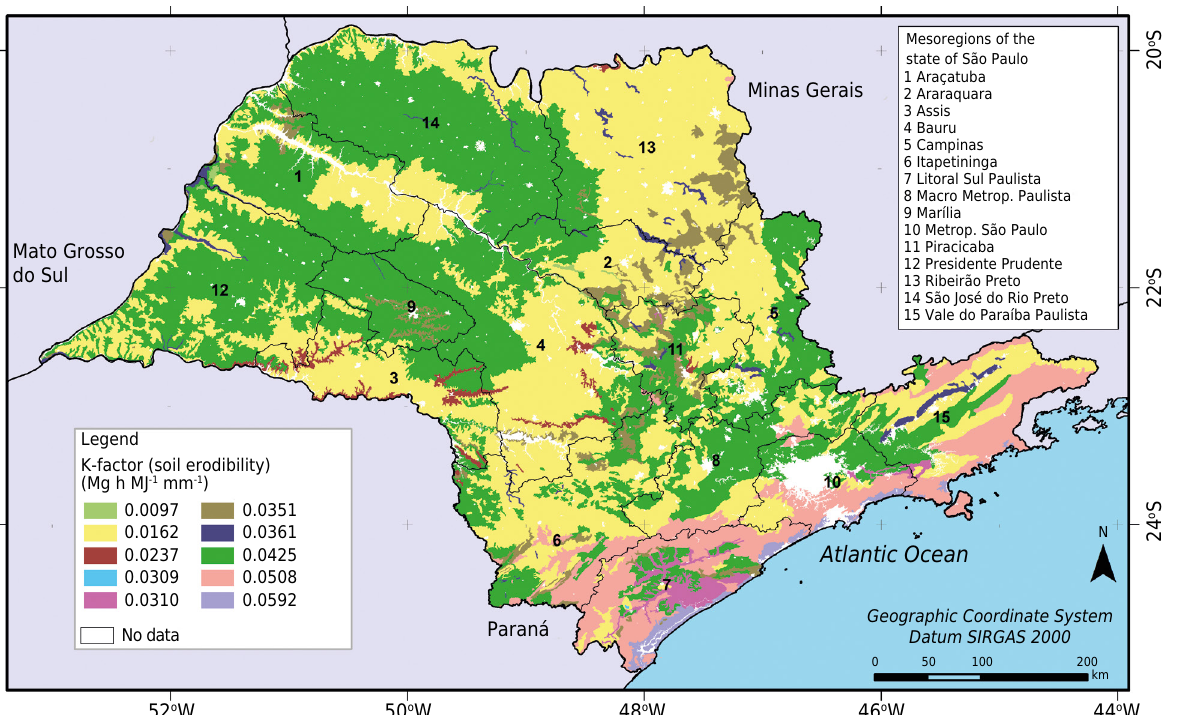
Figure 4. K-factor map of the state of São